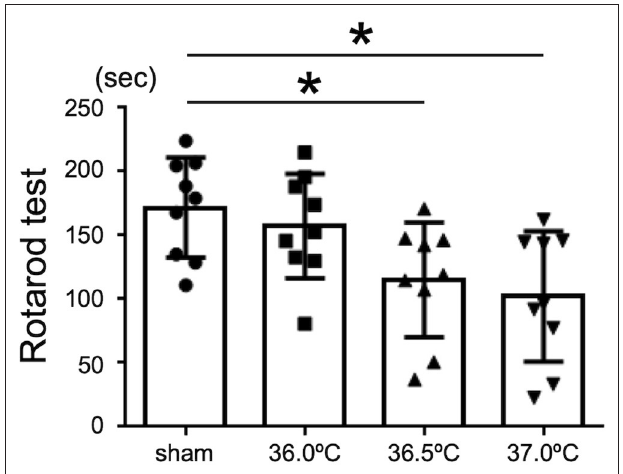
FIGURE 5 | Differences in motor function tests due to ambient temperature in HIE mice. Rotarod test was performed for the evaluation of motor function in HIE mice 2 weeks after hypoxia at temperatures of 36.0 ◦ C, 36.5 ◦ C, or 37.0 ◦ C. (sham, •, n = 9; 36.0 ◦ C, (cid:4) , n = 9; 36.5 ◦ C, N , n = 9; 37.0 ◦ C, H , n = 9). * p < 0.05. Error bars show means +